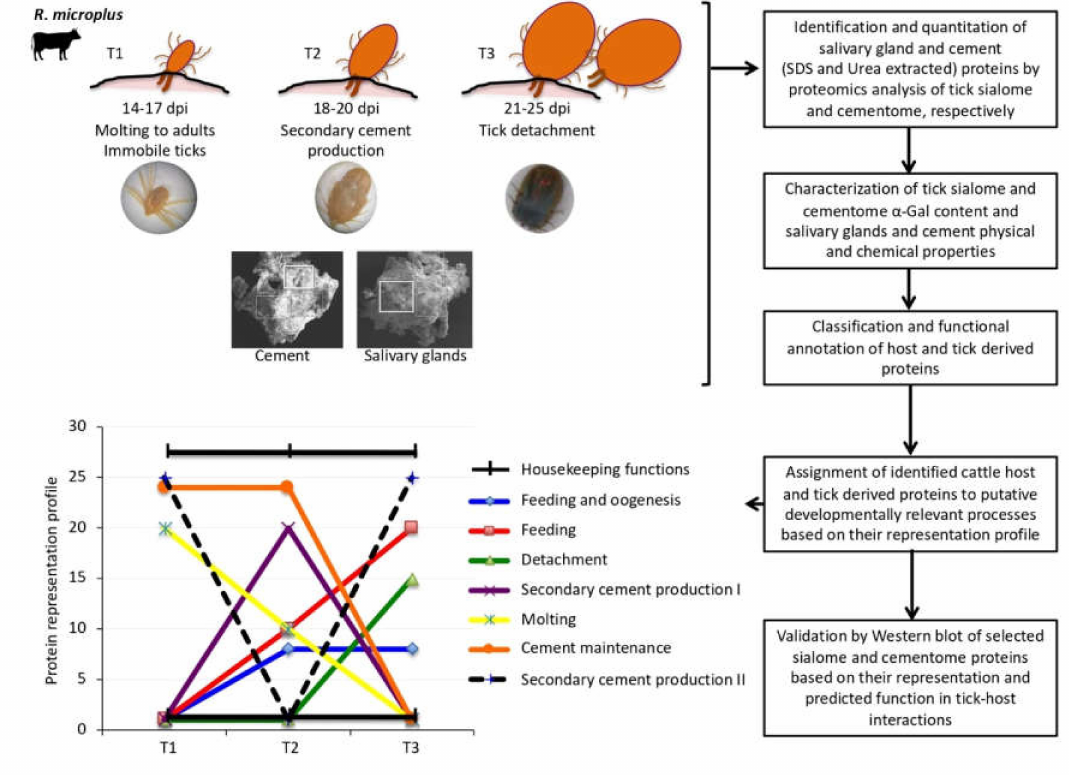
Figure 1. Experimental design. The sialome, cementome, and salivary glands and cement physical and chemical properties were characterized in R. microplus adult female ticks during feeding on cattle in samples collected at three time points corresponding to 14–17 dpi (T1; immediately after molting to adults immobile ticks), 18-20 dpi (T2; during secondary cement production), and 21–25 dpi (T3; just prior to tick detachment). After protein extraction, proteomics was used for the identification,